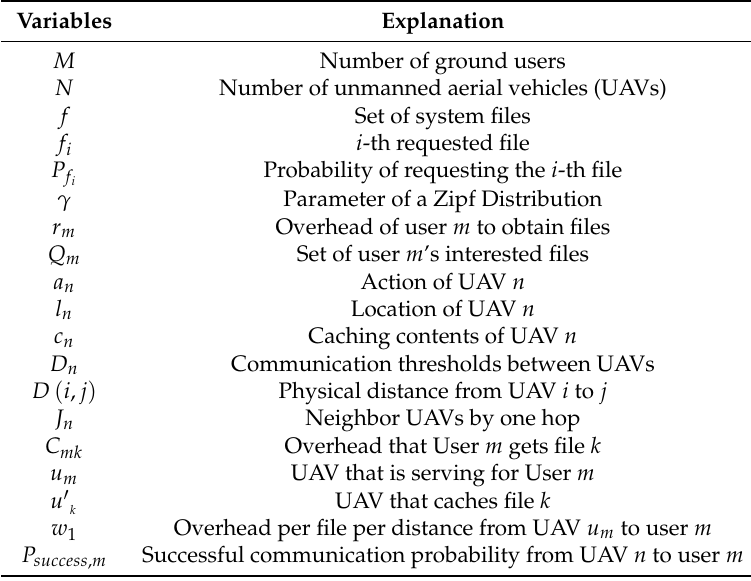
Figure 1. An illustration of the emergency communications network (1). The small unmanned aerial vehicles (UAVs) obtain the caching contents by the given decision from the central UAV and fly to the destination with cached contents. (2). UAVs cooperate with reachable neighboring UAVs by one hop. (3). UAV will fly to some UAVs with caching contents that the dedicated user wants. (4). UAV will return to the central UAV to get files if other UAVs cannot provide such services.). Table 1. Key variables used in this